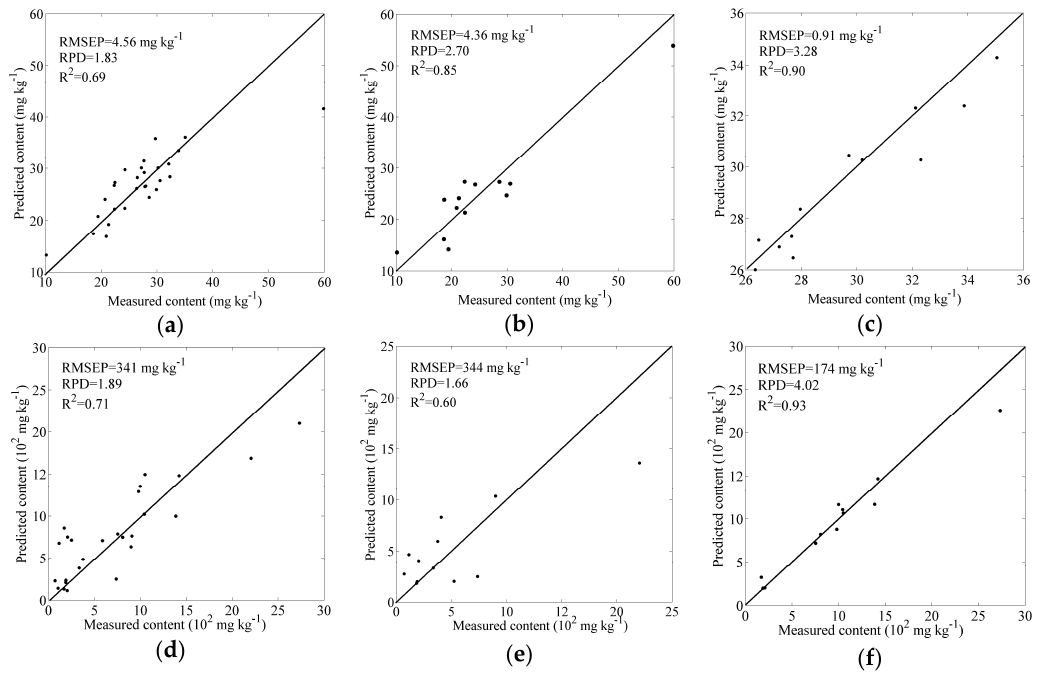
Figure 5. ( a – f ) Scatter plot of the measured against predicted concentrations: ( a , d ) scatter plots of 74 soil samples for Ni and Zn, respectively; ( b , e ) scatter plots of Group E1 for Ni and Zn, respectively; and ( c , f ) scatter plots of Group E2 for Ni and Zn, respectively.